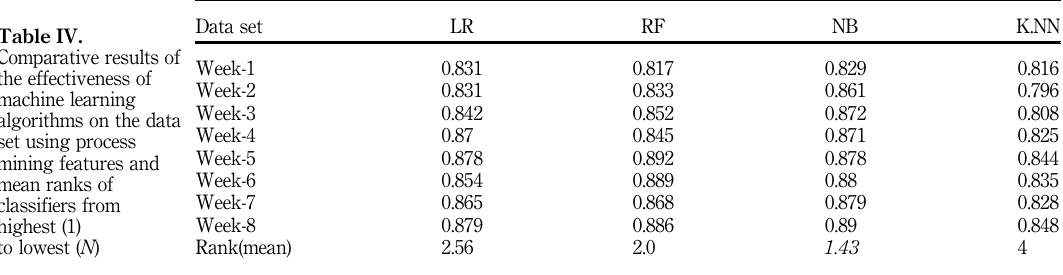
Table IV. Comparative results of the effectiveness of machine learning algorithms on the data set using process mining features and mean ranks of classifiers from highest